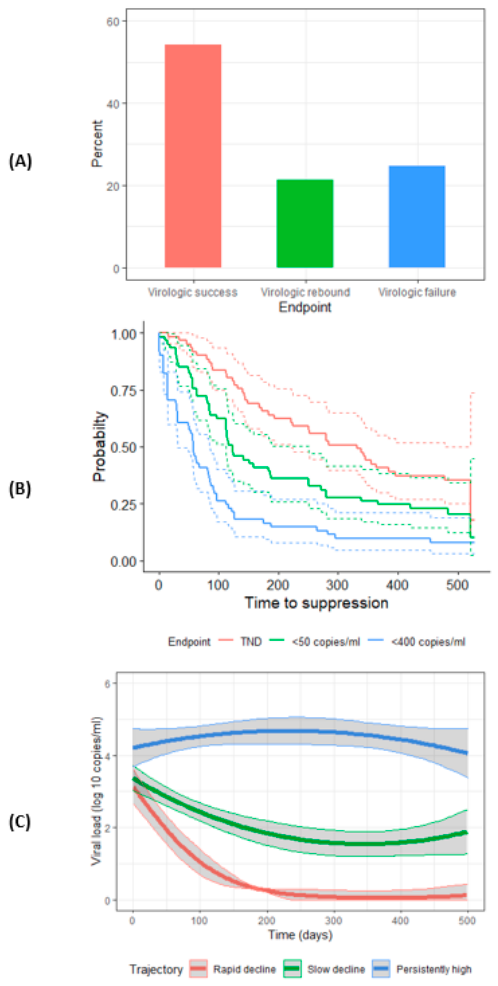
Figure 1. Pattern of viral response through 72 weeks for 61 intrauterine HIV-infected neonates by three methods. ( A ) Bar graph depicting percentage of participants with each clinically-meaningful viral load endpoint (virologic success, rebound, and failure) through 72 weeks. ( B ) Kaplan–Meier curves depicting probability of achieving a viral load <400 copies/mL, <50 copies/mL, and target not detected (TND) by 72 weeks; dotted lines represent 95% confidence intervals. ( C ) Trajectories of viral load (log10 copies/mL) through 72 weeks of age as determined by latent class growth model; bands represent 95% confidence intervals.